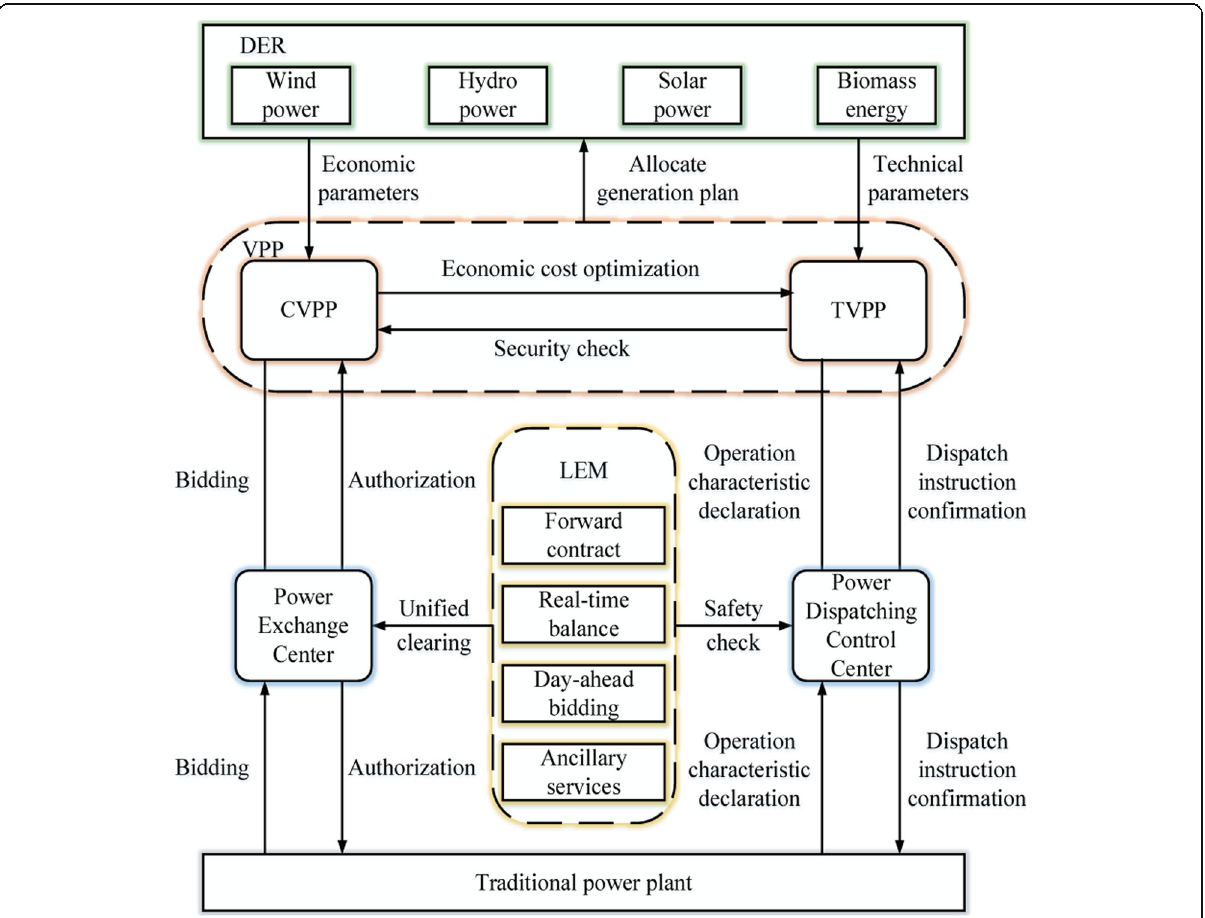
Fig. 2 Information interaction and operation flow of virtual power